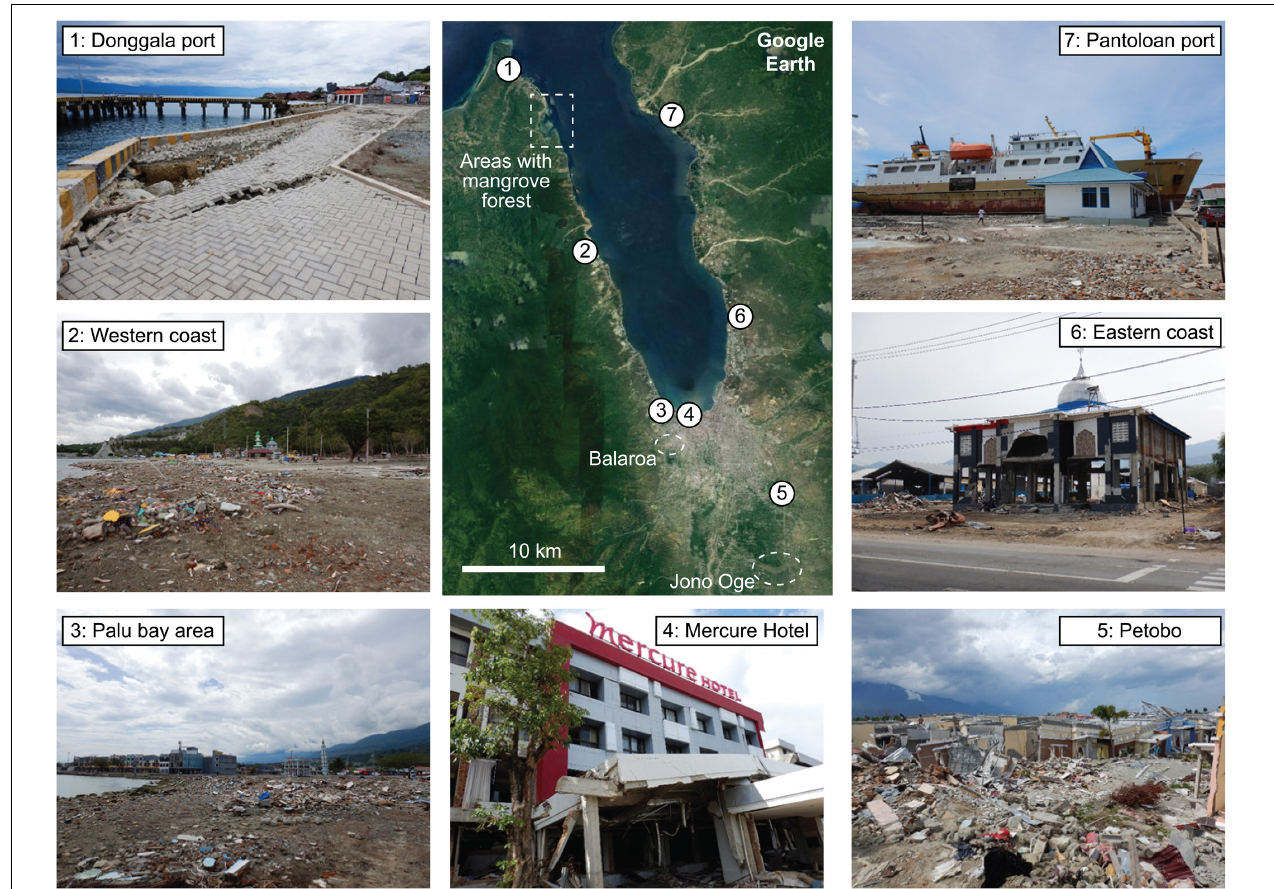
FIGURE 2 | Earthquake damage at a glance around Palu Bay. The base satellite image is obtained from Google